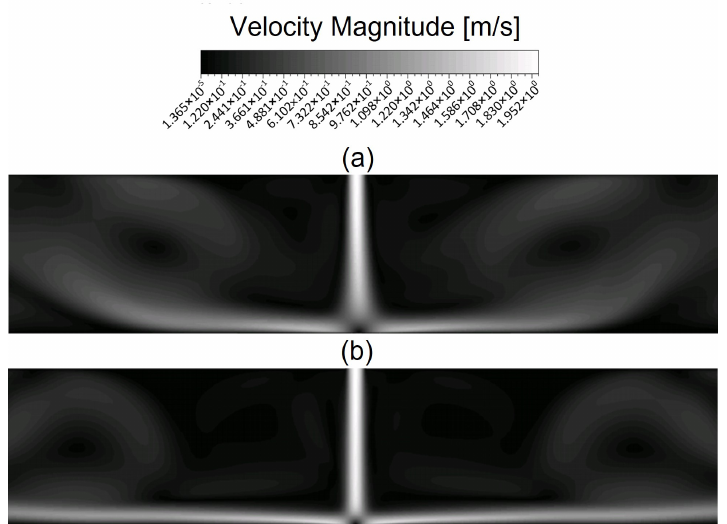
Figure 7. Velocity magnitude contours for ( a ) unsteady laminar (time-averaged) and ( b ) steady